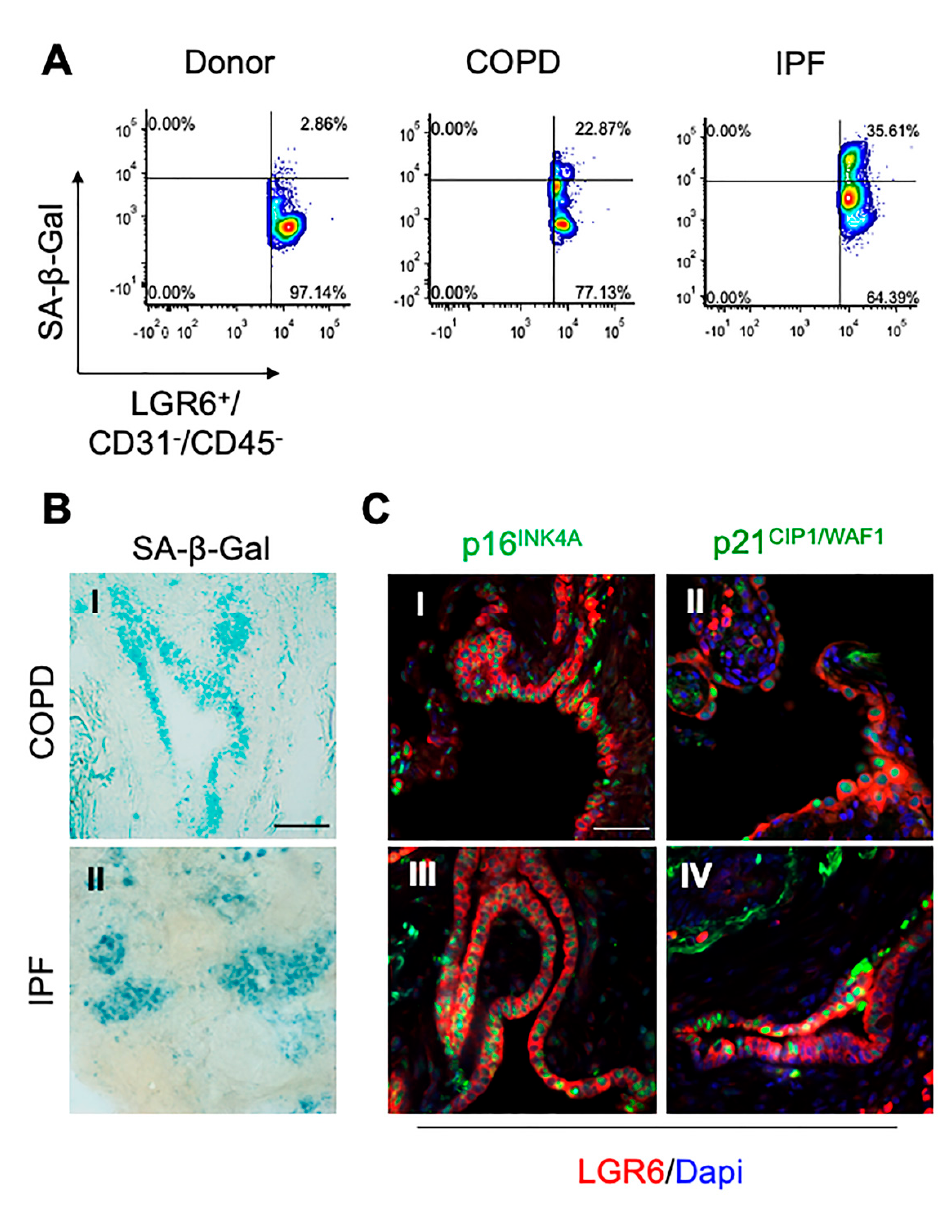
Figure 3. LGR6+ cells express increased levels of senescence-associated markers. ( A , B ) SA- β -Gal enzymatic activity was evaluated in donor, COPD and IPF cells isolated from freshly dissected lung biopsies ( A ). SA- β -Gal expression was confirmed in bronchoalveolar compartment of COPD and IPF tissues (( B ); bar = 100 µ m). ( C ) Representative photomicrographs showing co-expression of LGR6 in red with p16INK4A (( I )–( III )) and p21CIP1/WAF1 (( II )–( IV )) in green in the bronchoalveolar compartment of COPD and IPF patients (( C ); scale bar = 50 µ m).